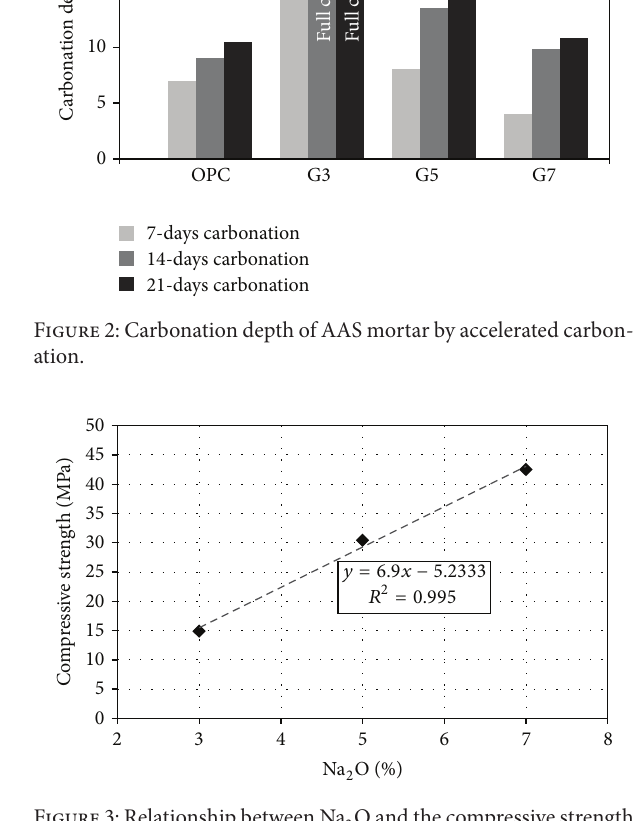
Figure 3: Relationship between Na 2 O and the compressive strength in AAS